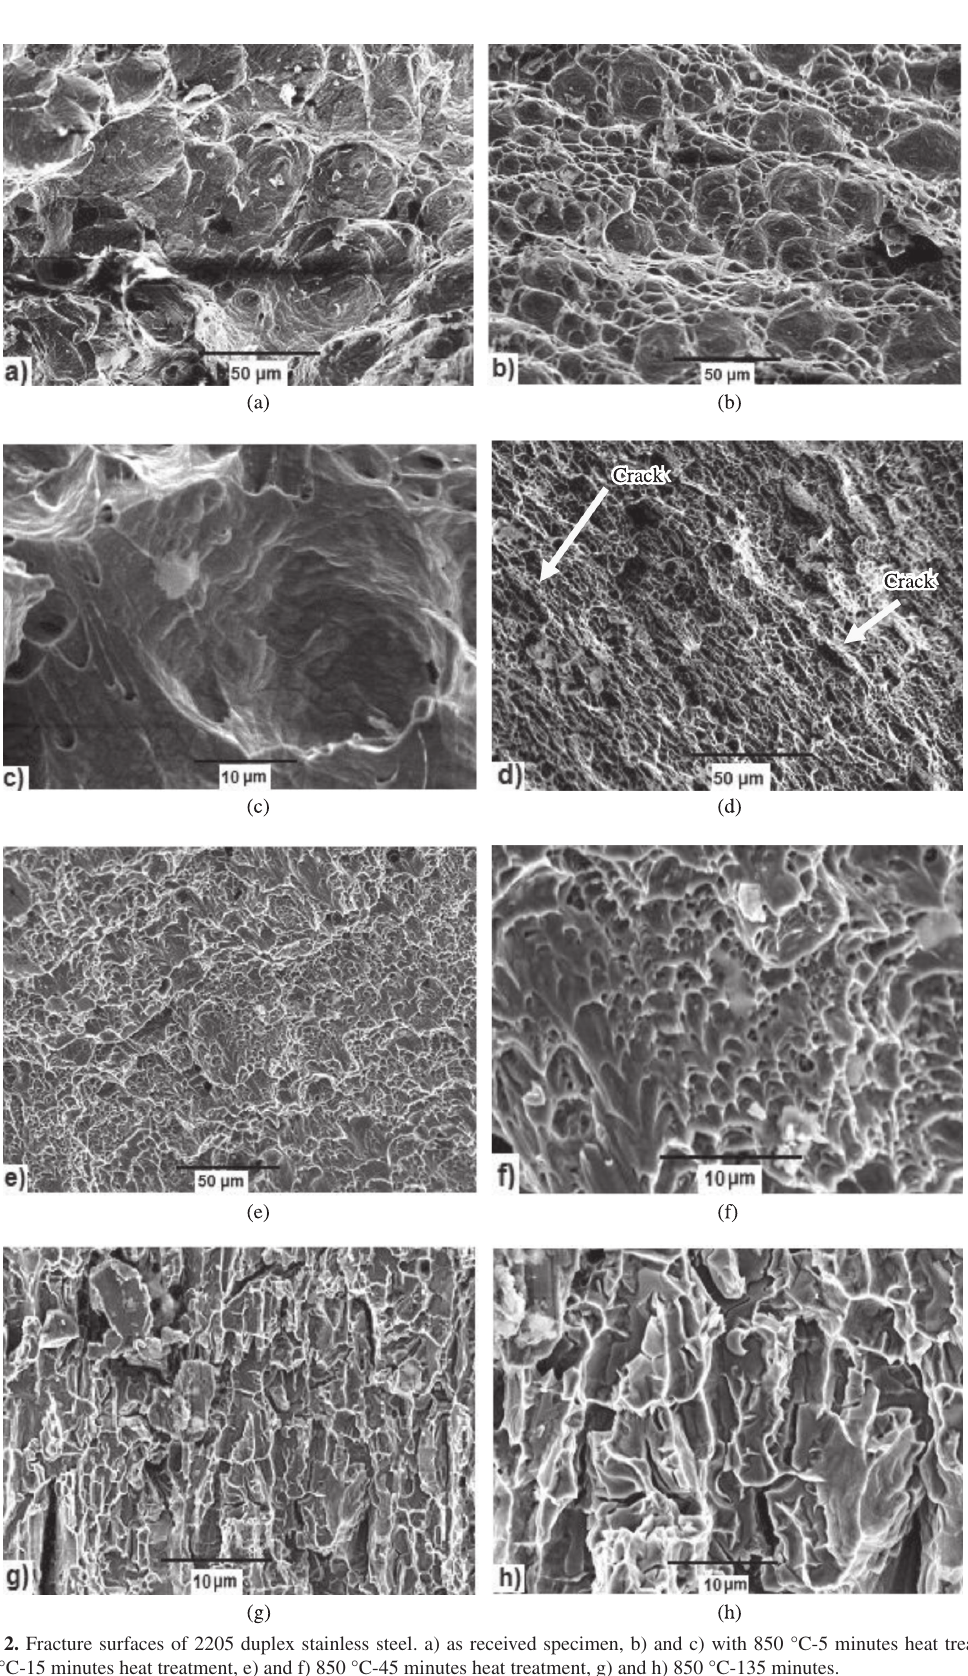
Figure 2. Fracture surfaces of 2205 duplex stainless steel. a) as received specimen, b) and c) with 850 °C-5 minutes heat treatment, d) 850 °C-15 minutes heat treatment, e) and f) 850 °C-45 minutes heat treatment, g) and h) 850 °C-135